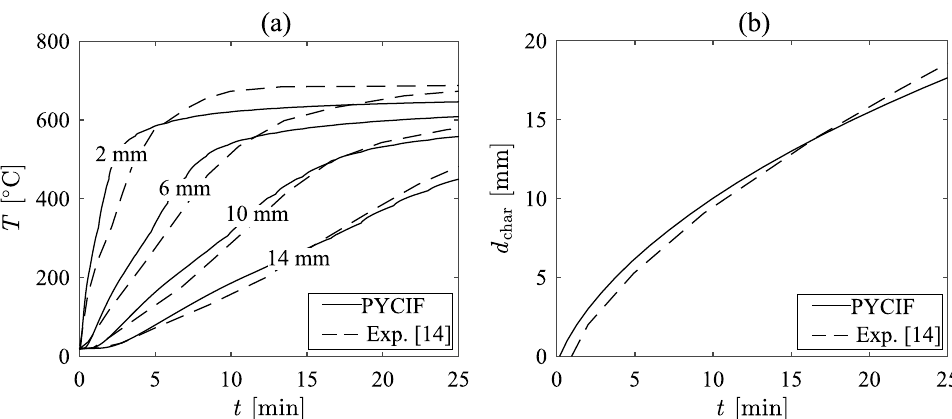
Fig. 8 Comparison of experimental and numerical results for 38.5 kW/m 2 cone calorimeter test. a The development of temperatures in different points of the specimen. b The development of charring depth